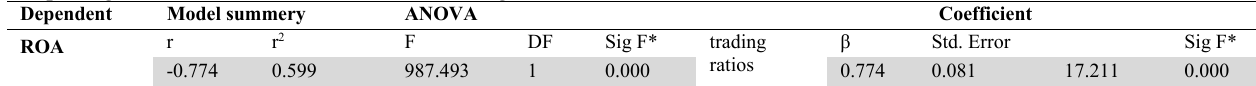
Simple regression test results, the effect of trading ratios at return on assets Dependent Model summery ANOVA